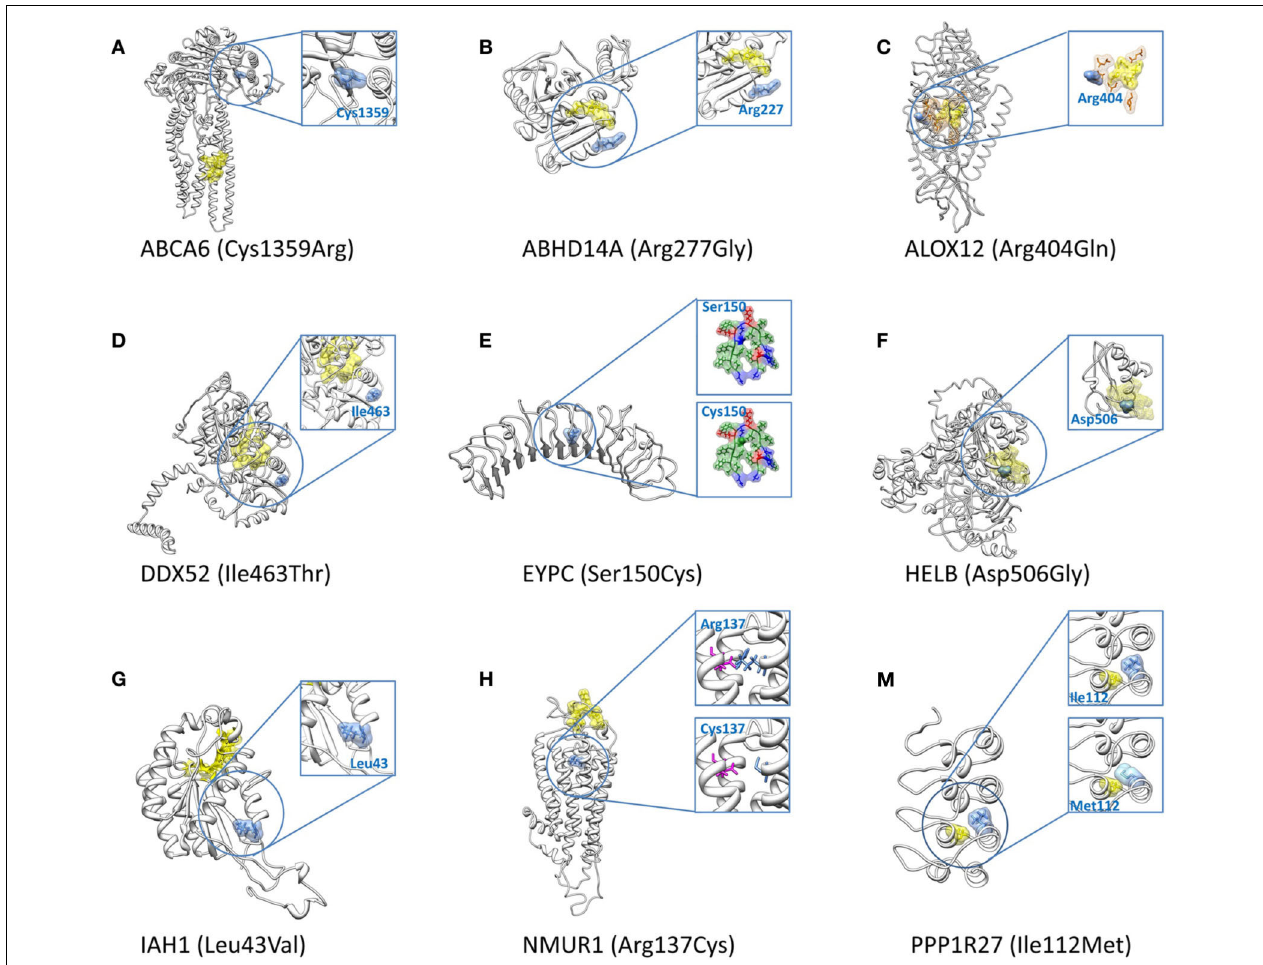
FIGURE 4 | 3D structures for the nine high-priority variants for epilepsy. The nine high-priority variants for epilepsy include eight structural disrupted variants (A–H) which locate in genes with high tolerance of polymorphisms ( Table 5 ) and one structural disrupted variant (M) which resides in a low tolerance gene ( Table 5 ). In all figures, mutated protein residues caused by the SNPs are indicated with blue surface representations along with the amino acid name (wild type) and residue index. Yellow surface representations refer to predicted binding sites or catalytic sites, except in